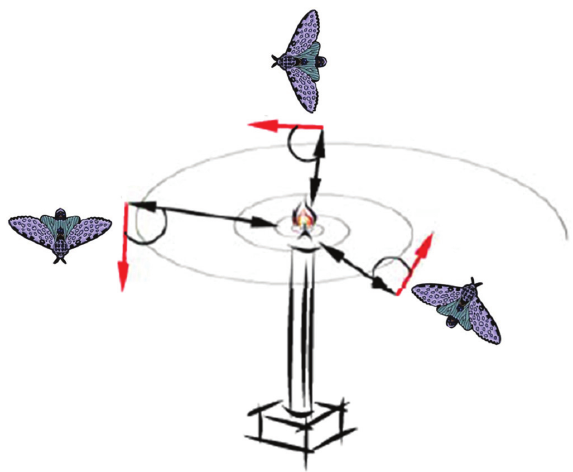
Figure 4: Spiral flying path around close light sources (Mirjalili, 2015).